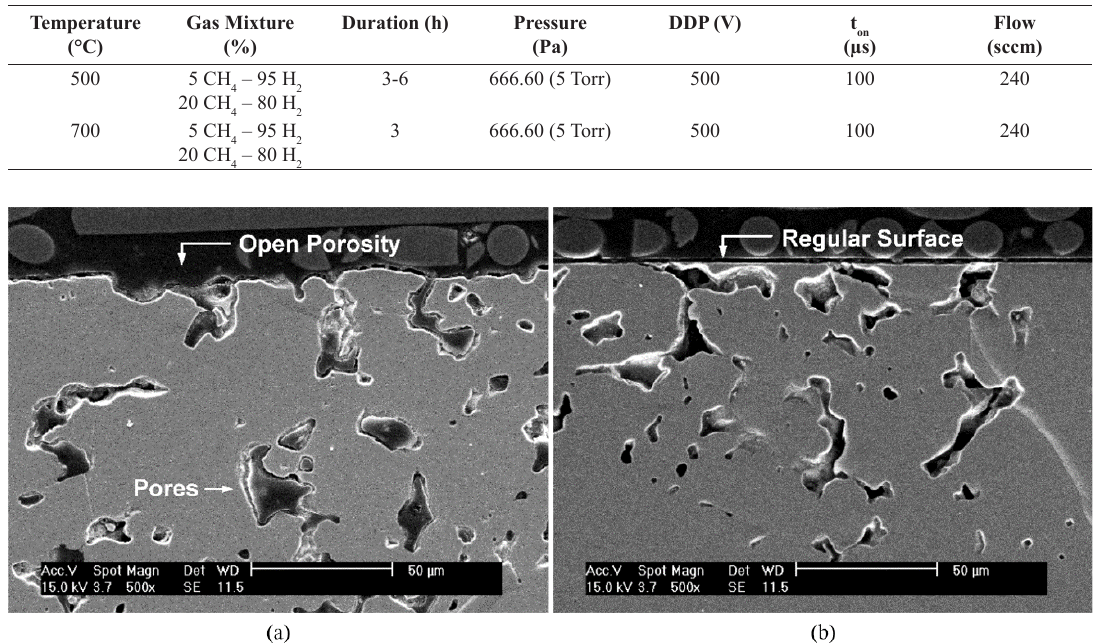
Figure 2. Cross-sectional micrographs of samples prior to carburization: (a) no metallographic procedure prior to carburizing; (b) ground and polished prior to treatment.